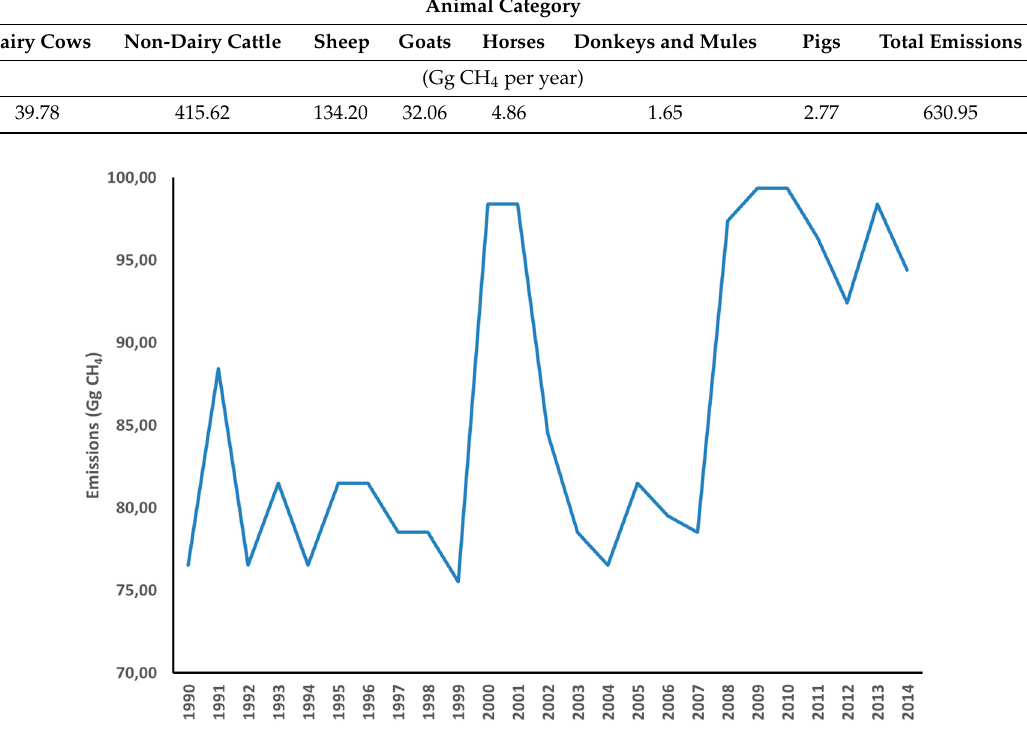
Figure 2. Enteric emissions (Gg CH 4 ) for South African dairy cattle from 1990 to 2014.